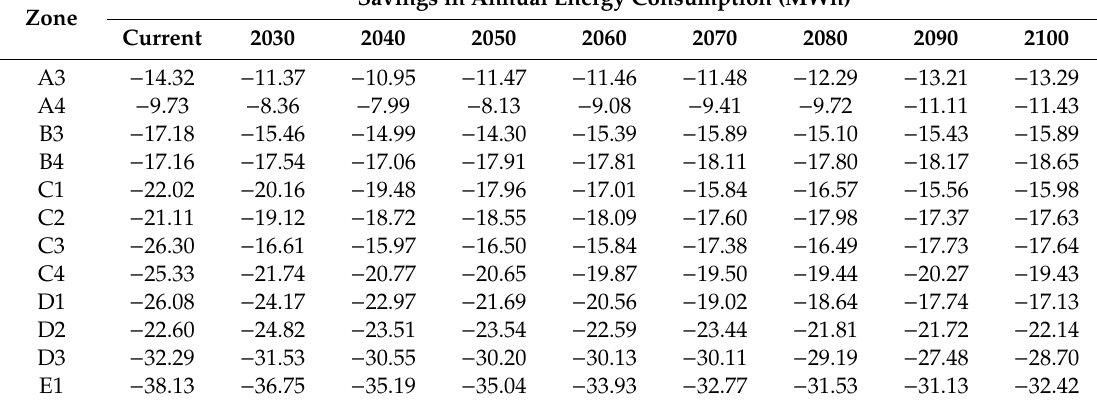
Table 9. Energy savings obtained with plasterboard considering an operational pattern of users working outside the